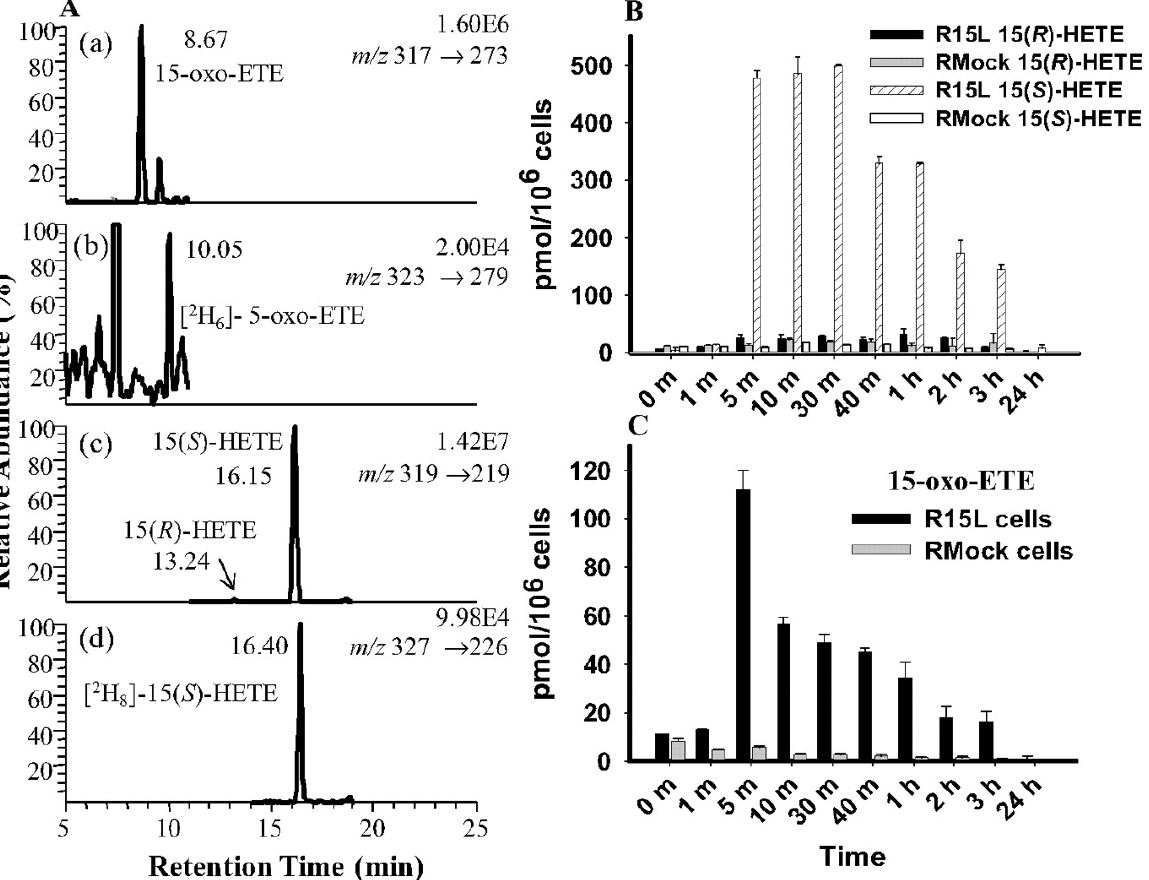
Figure 7. LC-SRM/MS analysis and quantitation of 15-LOX-derived eicosanoids from R15L cells and RMock cells treated with arachidonic acid. A, representative chromatograms of 15-LOX-derived lipid metabolites released by R15L cells after 5-min treatment with 10 μ M arachidonic acid. SRM chromatograms are shown for 15-oxo-ETE- PFB ( m / z 317 → 273) (a), [ 2 H ]5-oxo-ETE-PFB internal standard ( m / z 323 → 279) (b), 15- 6 ( R,S )-HETE-PFB ( m / z 319 → 219) (c), and [ 2 H ]15-( S )-HETE-PFB internal standard 8 ( m / z 327 → 226) (d). B, concentration-time graph of 15-HETE ( R - and S -form) released by R15L or RMock cells treated with 10 μ M arachidonic acid for 24 h. C, concentration-time graph of 15-oxo-ETE released by R15L or RMock cells treated with 10 μ M arachidonic acid for 24 h. Cell supernatants were collected at each time point. Lipid metabolites in the cell supernatants were extracted and derivatized with